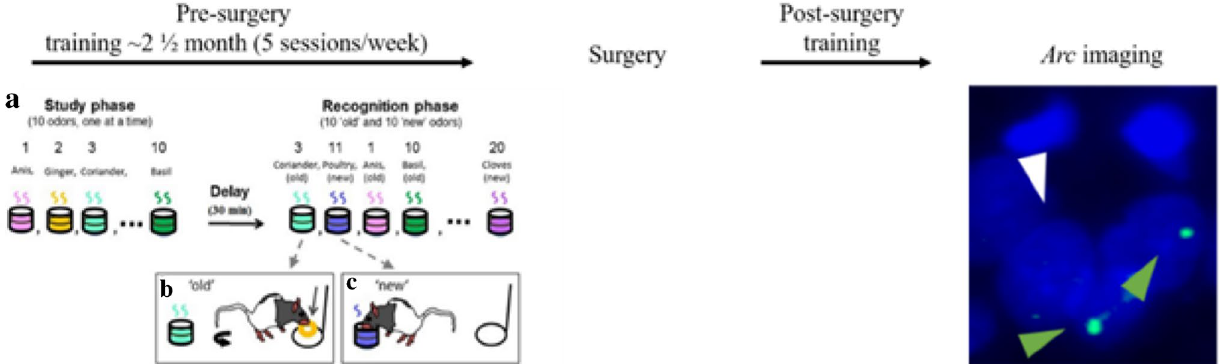
Figure 1. Overview of the experimental design. Left: Pre-surgery training. ( a ) Ten odors are presented to the animal during the study phase (one at a time). After a 30 min delay, the memory for the studied odors is tested by presenting the same odors intermixed with 10 new odors to the animals (also one at a time). ( b , c ) Delayed nonmatching-to-sample rule. If the odor belonged to the study list (old odor), the rat was expected to refrain from digging and turn around to get a food reward at the back of the cage ( b ). If the odor did not belong to the study list (new odor), the rat could dig in the stimulus cup to retrieve a buried reward ( c ). Right: After reaching the criterion, HIP and sham-surgeries were performed. After recovery, post-surgery training lasted until rats reached a plateau performance on 3 consecutive days subsequently to which rats were sacrificed and their brain processed for Arc imaging (green arrowheads: examples of Arc positive cells, white arrowhead: Arc negative cell, nuclei are counterstained with DAPI) (Adapted from Nakamura et al.